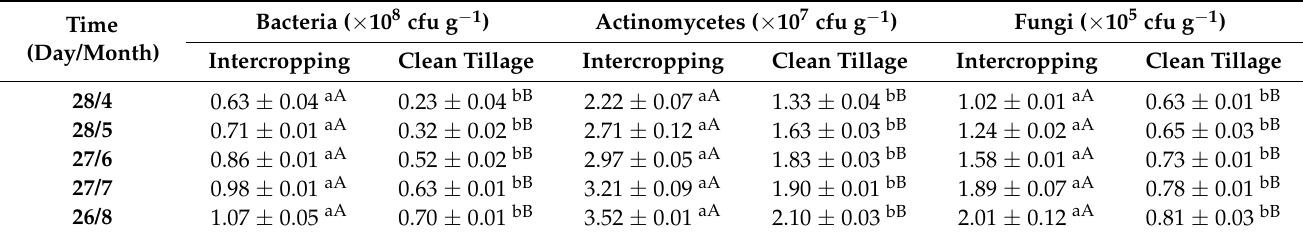
Values indicate the mean ± SD of three replicates. Different small and capital letters in the same row indicate significant differences at 5% level ( p < 0.05) and 1% level ( p < 0.01) between intercropping and clean tillage,